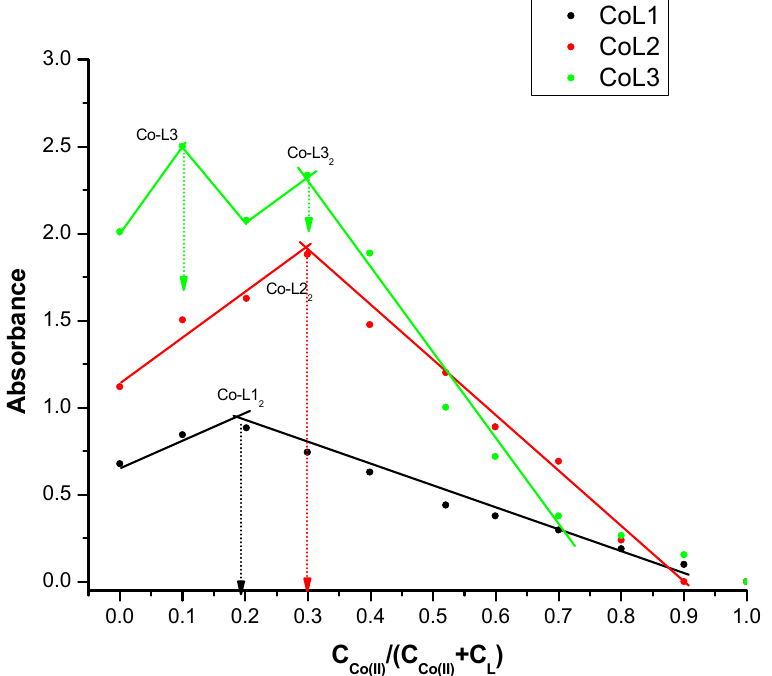
Figure 8. Graphical representation of the dependence A = f(C Co(II) /(C Co(II) + C L ) (Job method) for so- lutions containing different content of metal ions (Co(II)) and ligand (L1, L2 and L3).